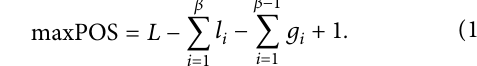
The algorithm traverses all substrings s i [ j · · · j + L − 1 ] ( 1 ≤ j ≤ | s | − L + 1 ) of length L in s i i in turn, calculates the score of s i [ j · · · j + L − 1 ] , and then obtains the